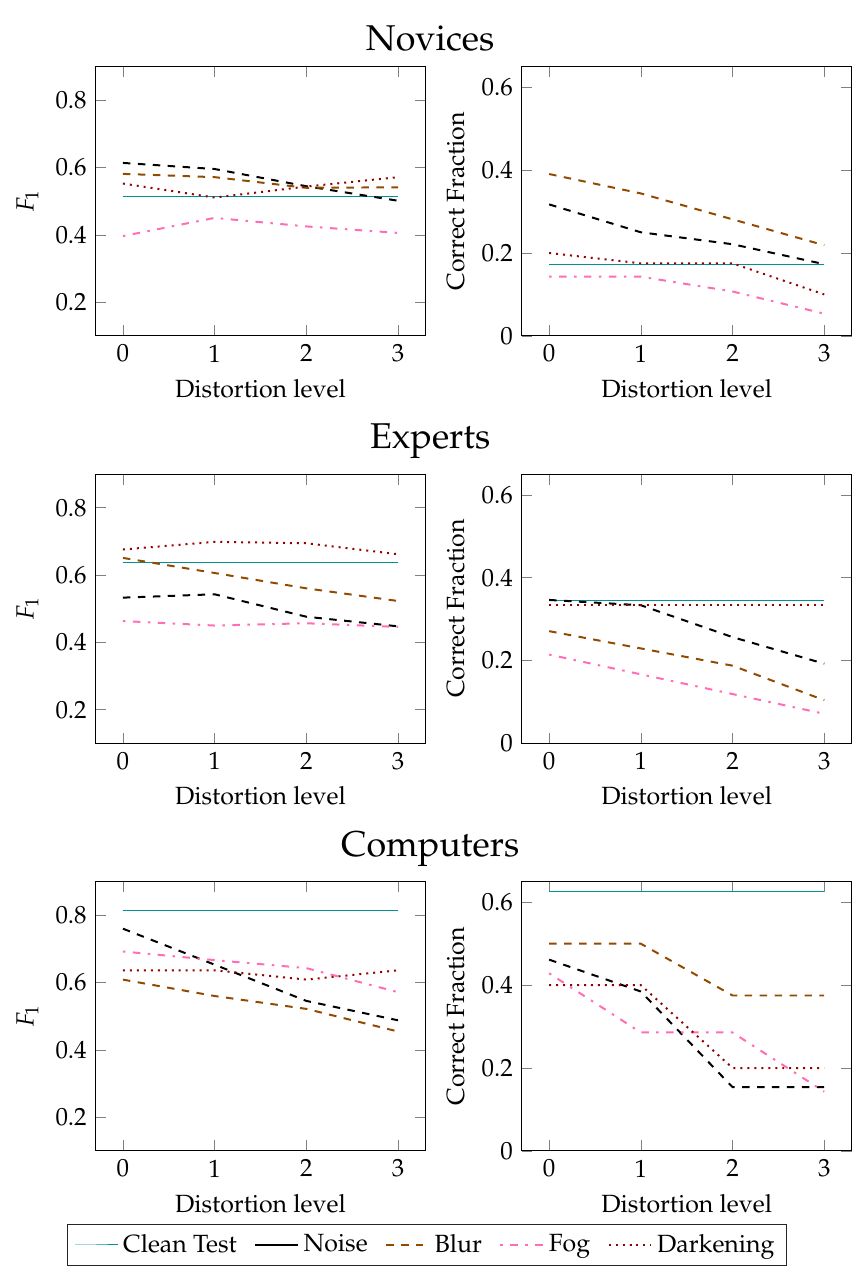
Figure 8. The F 1 score and the fraction of correctly classified images, for novices, experts, and computers. Note that while the datasets used for this testing contained the same images as in the rest of the results, they were split into one test set for each type of distortion. Furthermore, no oversampling of the test set was performed, to keep the results from the computer comparable to the ones from the humans.